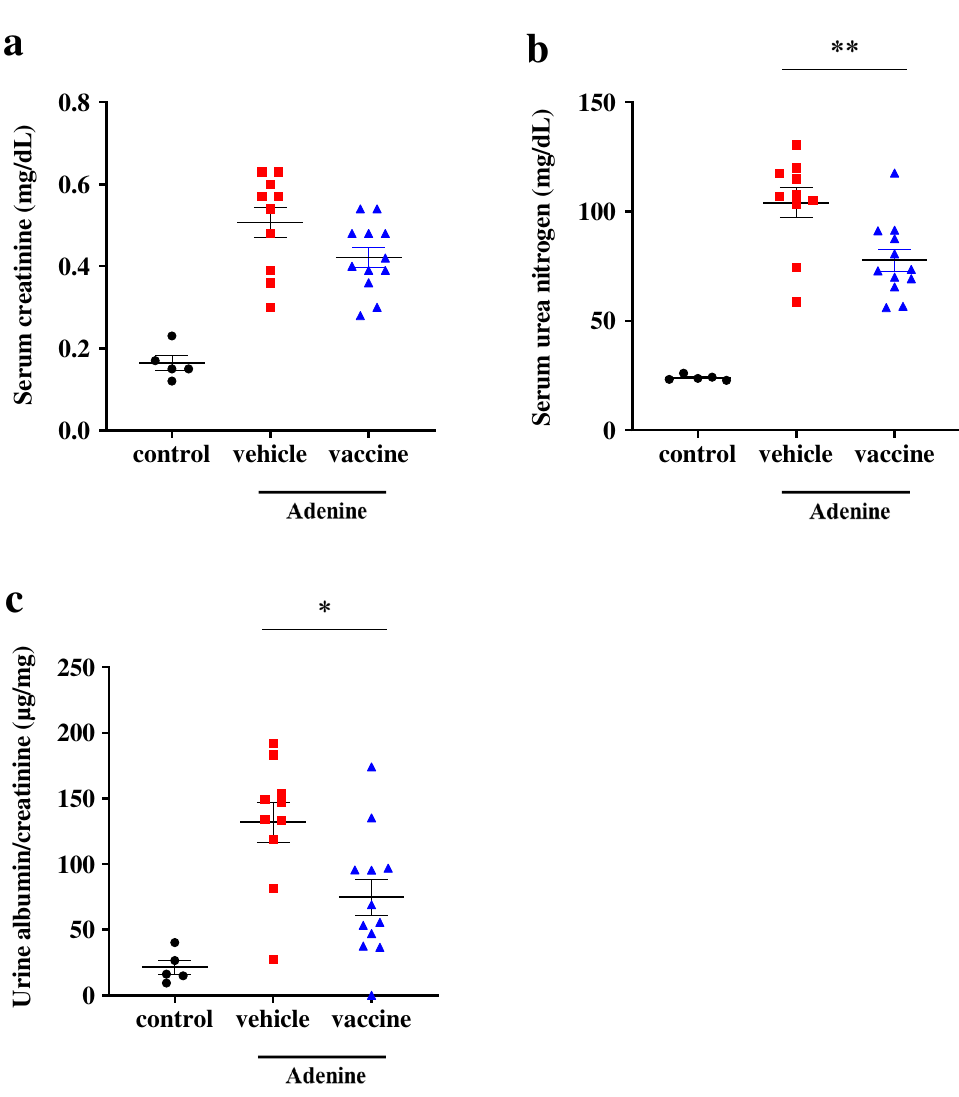
Figure 2. Effects of the CTGF vaccine on renal functions in the adenine-induced CKD model. Male C57BL/6 J mice were inoculated with the KLH vehicle or CTGF vaccine. Blood and urinary samples were collected after feeding the mice a rodent diet containing 0.2% adenine for 3 weeks ( n = 10–12/group). ( a ) Serum creatinine and ( b ) urea nitrogen levels were measured, and ( c ) urine albumin/creatinine ratios were calculated. Error bars show mean ± SEM. Statistical difference between the KLH vehicle and CTGF vaccine group was determined by using Student’s t -test. ** P < 0.01; * P < 0.05 as compared with the